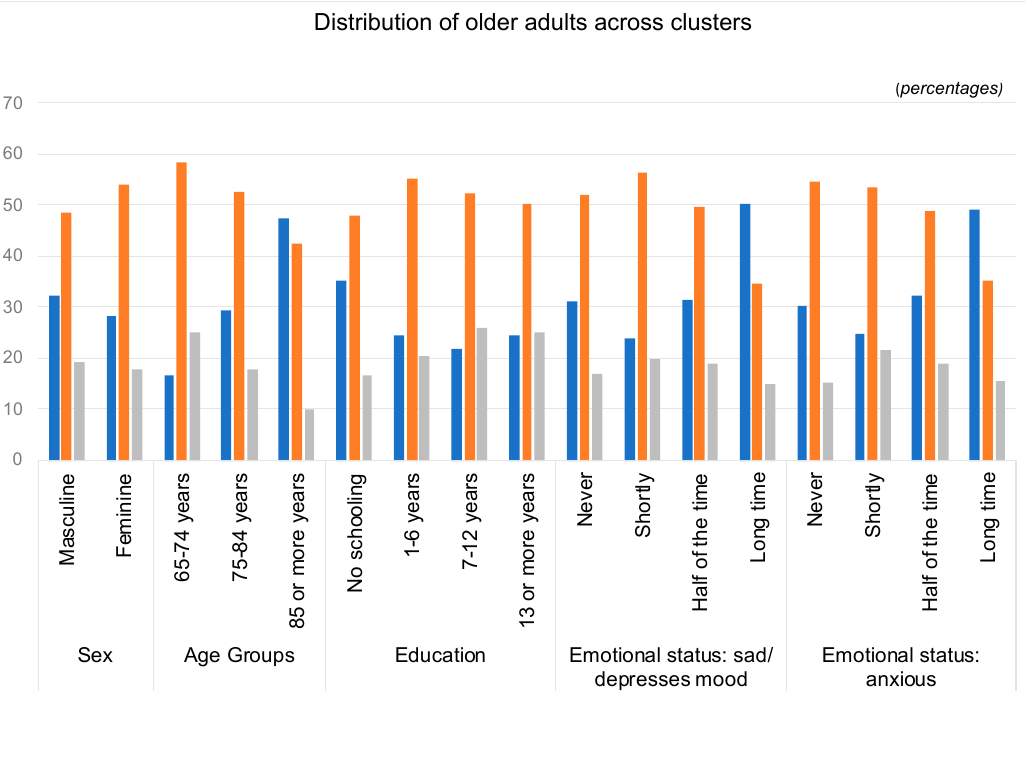
Figure 3. Distribution of people aged 65 years or older in the convalescence units by sex, age group, education level, emotional state: sad/depressed and emotional state: anxious, per cluster.